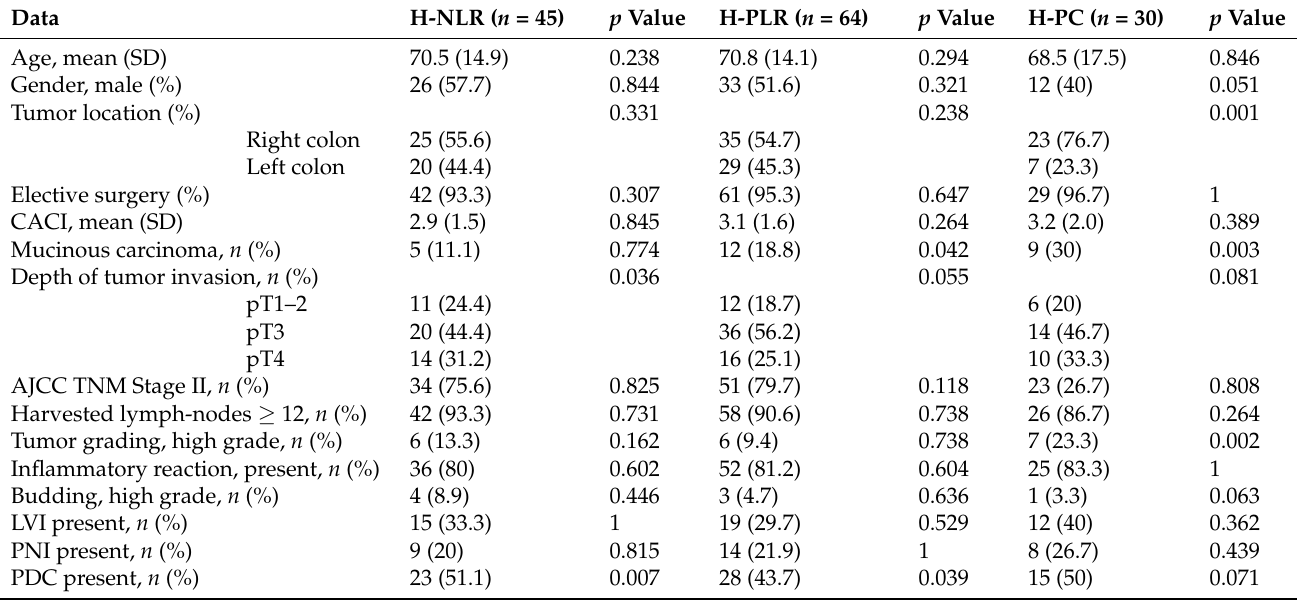
Figure 1. CONSORT diagram for patient inclusion. Table 1. Correlations between NLR, PLR and PC and main clinical and pathological variables for the 107 patients under